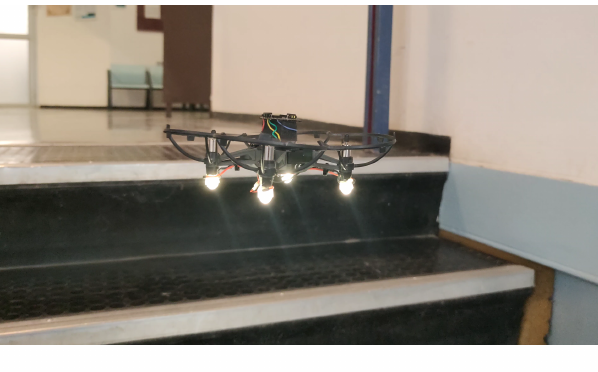
Figure 7. BAT exploring a corridor.